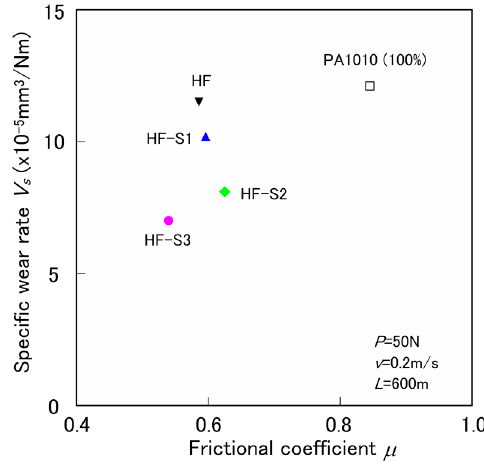
Figure 3. Tribological properties ( P = 50 N, v = 0.2 m/s, and L = 600 m) of various surface-treated HF/PA1010 biomass composites.